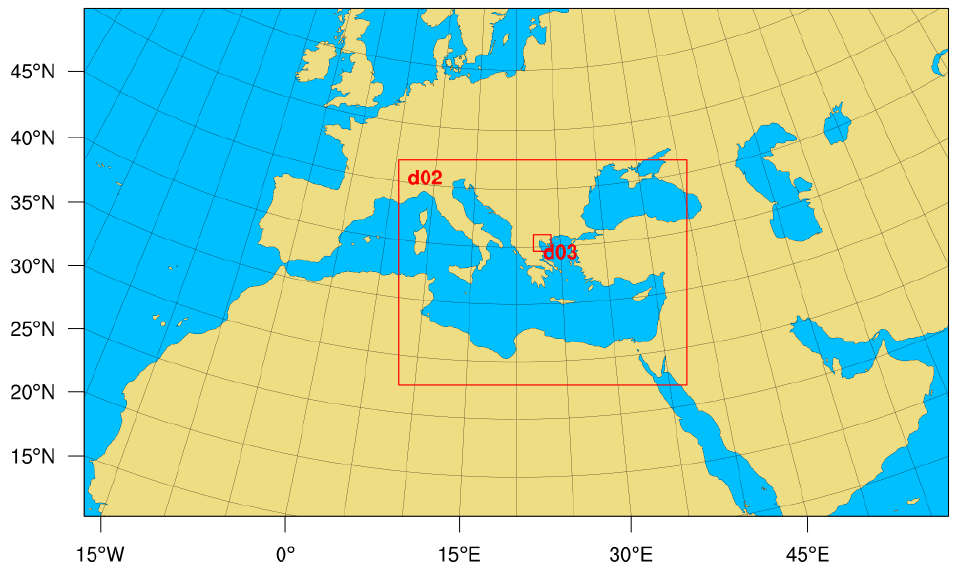
Figure 1. Setup of the WRF model domains.